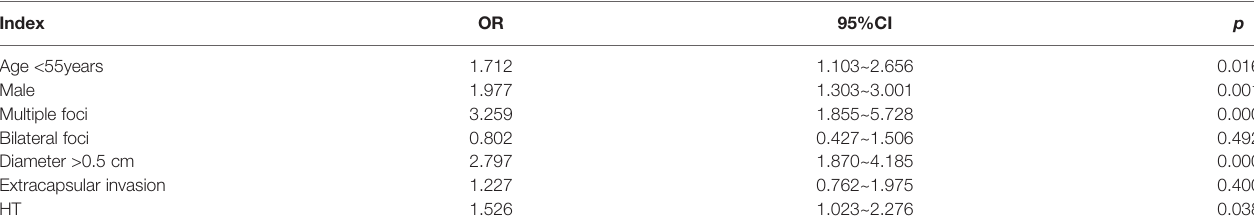
TABLE 3 | Multivariate logistic regression analyses to identify independent affecting risk factors of